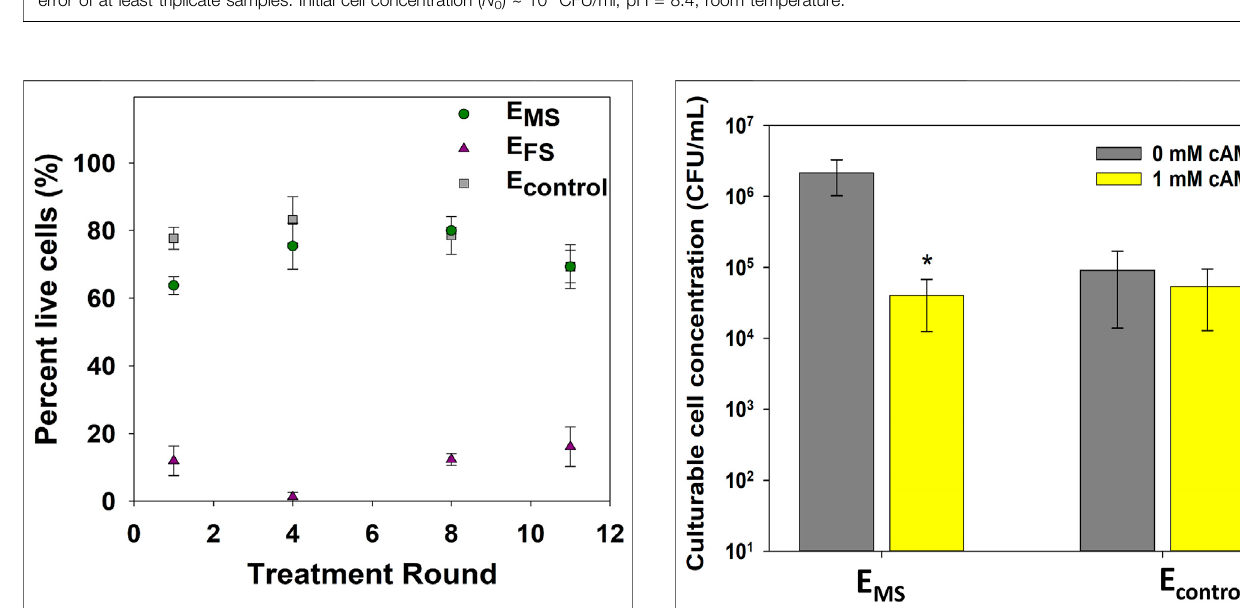
FIGURE2| E.coli log 10 inactivationaftermultipleroundsofgrowthanddisinfectionwitheither2.5 mg/LasCl 2 ofmonochloramineor11.2 mg/LasFeofferrate. (A) Bacterial inactivation of E MS due to repeated monochloramine disinfection. (B) Bacterial inactivation of E FS due to repeated ferrate disinfection. E control cultures were not repeatedly treated;separatealiquotsoftheE control wereobtainedat selectrounds andtreatedforcomparison. Rounds inwhichstressed cultureswereregrownwithout exposuretodisinfectionarepresentedafterthedashedline.Eachdatapointrepresentsanaverageofatleasttriplicatesamples.Errorbarsrepresentonestandard error of at least triplicate samples. Initial cell concentration ( N 0 ) ~ 10 8 CFU/ml; pH = 8.4; room temperature.